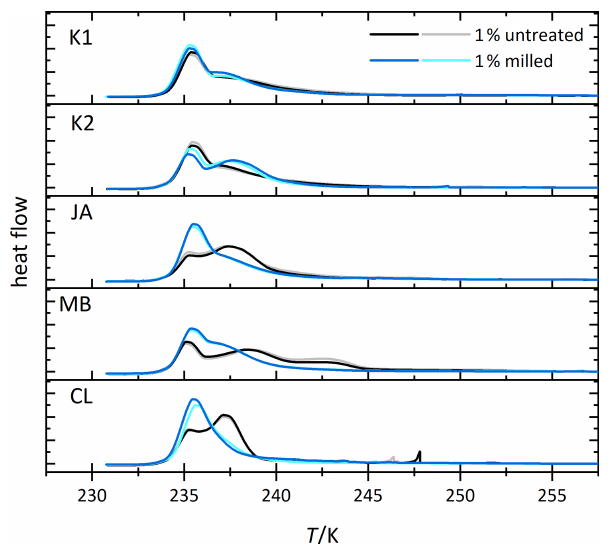
Figure 4. Thermograms from immersion freezing experiments of emulsified 1wt% dust suspensions of kaolinites and selected hal- loysite samples (black/gray) and the corresponding measurements of the milled samples (blue/cyan). The curves are normalized with respect to their total integral. (Spikes occurring before the heteroge- neous freezing signal originate from single large emulsion droplets and are not representative of ice nucleation by halloysite/kaolinite). Dust sample codes are identical to those in Fig. 2.